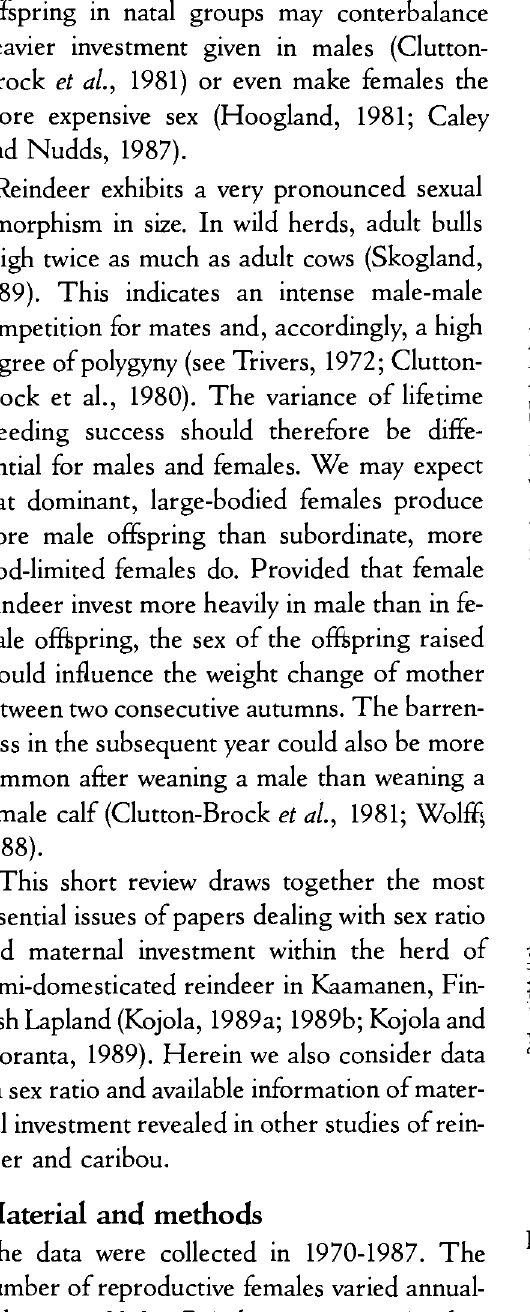
Fig. 1. Post-breeding weights of cows as functions of maternal age (left) and parity (right) are shown separately according to sex of the subsequent progeny. (Kojola and Eloranta, 1989). Statistical tests are given in the text. The sex of the calf accounted for more of the variation in the maternal body weight than ma ternal age (F = 5.4, df= 1.880, p = 0.020) or the parity (F = 4.4, df=1.713, p = 0.036)